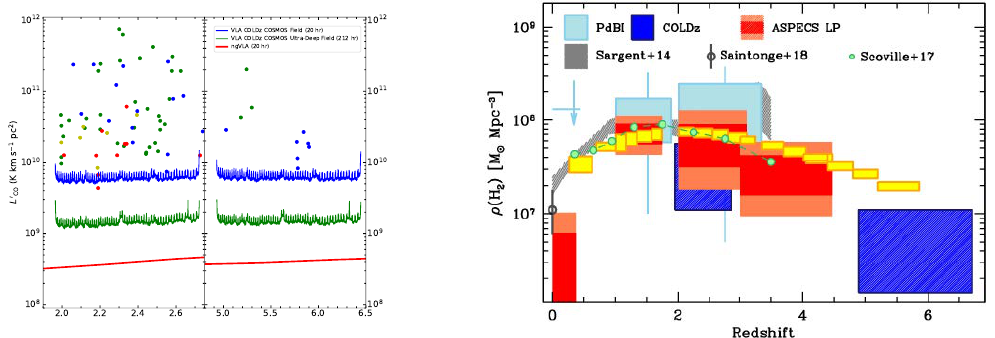
Figure 4. ( Left )—CO line luminosity sensitivity limits (i.e., 3 σ rms noise at a line FWHM of 200kms − 1 ) for a number of existing surveys in the literature shown as a function of redshift. The corresponding sensitivity of the ngVLA is shown for a 20h integration, which is roughly an order of magnitude better than what is currently possible. The different plotting colors identify different galaxy types (Green: “dusty galaxies” include sub-mm galaxies, extremely red objects, and 24 µ m selected galaxies; Red: “color-selected galaxies” include Lyman-break, BzK, and BMBX galaxies; Blue: Quasars; Yellow: Radio galaxies), which clearly indicate that significantly more sensitive observations (i.e., those achievable with the ngVLA) are required to detect large populations of typical galaxies that represent the bulk of the luminosity function beyond z (cid:38) 3. (Adapted from [71], COLDz Ultra-Deep Field limit from D. Vieira et al., in preparation). ( Right )—The evolution of the cosmic molecular gas density showing existing constrains from NOEMA, ALMA, and the VLA that point to a similar decrease in cold gas content once beyond z ∼ 2, which is similar to what is observed for the cosmic star formation rate density over cosmic time. However, current uncertainties are extremely large, demonstrating the need for a factor of ∼ 100 improvement in current survey speed to distinguish different mechanisms that can lead to the observed galaxy build-up. The ngVLA will deliver such an improvement as illustrated by the yellow data points which show the precision that would be reached by a 1000h survey. (Reproduced from